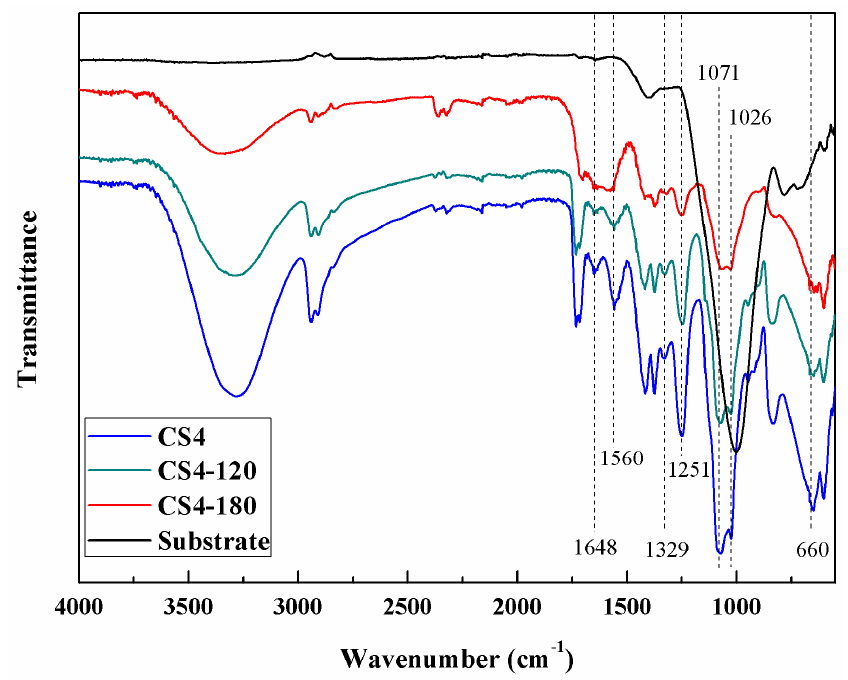
Figure 2. ATR–FTIR spectra of composite Figure 2. ATR−FTIR spectra of composite membranes.